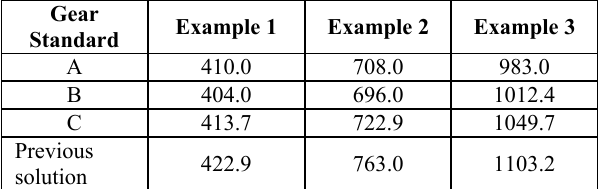
Table 2: Contact Stress Estimates in MPa